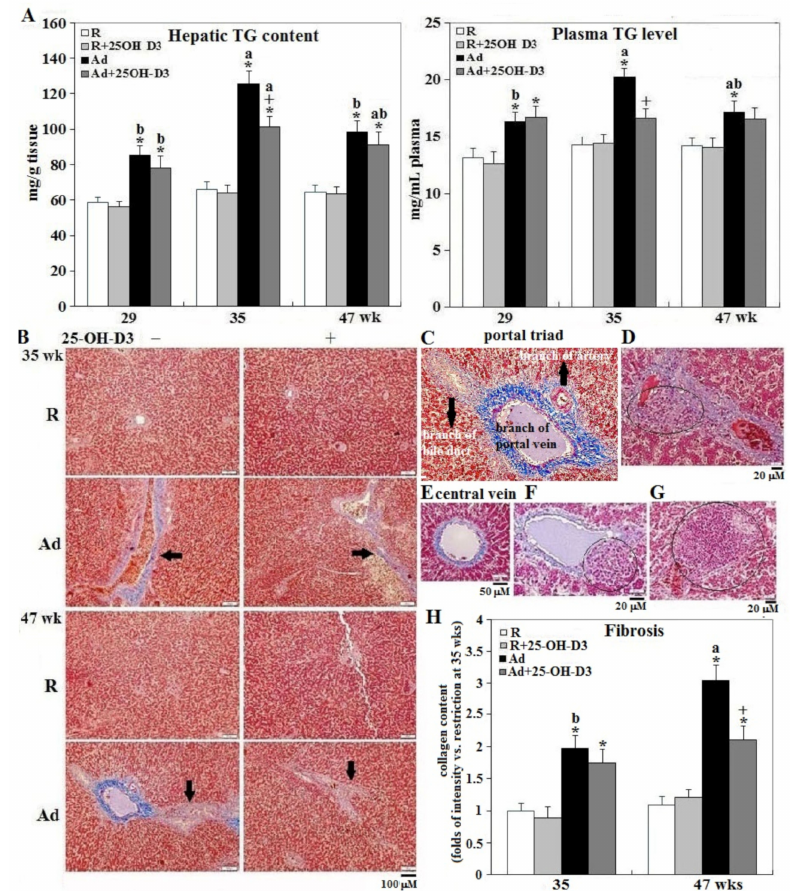
Figure 5. E ff ect of dietary 25-OH-D3 supplementation on plasma and hepatic triacylglycerol content and hepatic fibrosis of broiler hens provided with restricted or ad libitum feed intake. At age of 29, 35, and 47 weeks, 4, 7, and 7 hens from each group were randomly selected for tissue collection and collected plasma and liver were used for triacylglycerol (TG) content (panel A ) analysis. In Trichrome Masson staining, connective tissue (collagens) stains blue showing fibrosis (panel B ). In addition to portal triad (panel C ) and central vein (panel E ) areas, Ad- and Ad + 25-OH-D3-hens showed pronounced interstitials fibrogenesis (indicated by arrows in panel B), piecemeal necrosis characterized by leukocytes infiltration (circle areas in panel D ), adenoma / carcinoma-like structure in the central vein (penal F ), and hepatocellular areas (panel G ). Results of intensity of fibrotic blue chromogen staining are expressed as ratios relative to R hens at 35 weeks (panel H ).*; significant di ff erence by Ad feeding (vs. corresponding R-hens, p < 0.05) + ; significant di ff erence by 25-OH-D3 inclusion (vs. corresponding R- or Ad-hens, p < 0.05). R; restriction, Ad; ad libitum, 25-OH-D3;